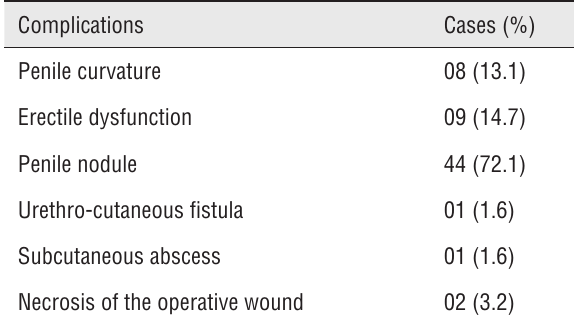
Table 2 - Postoperative complications after penile fracture surgical